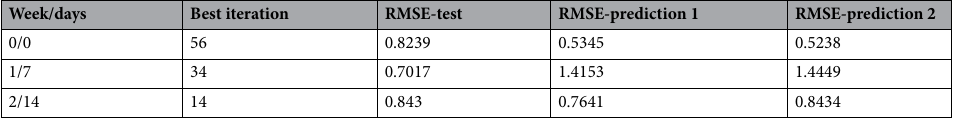
Table 3. Root mean square error (RMSE) obtained for each database from the adjusted predictive model. RMSE-test = error of the model fitted by default; RMSE-prediction 1 = error of prediction without hyperparameters; RMSE-prediction 2 = error with use of